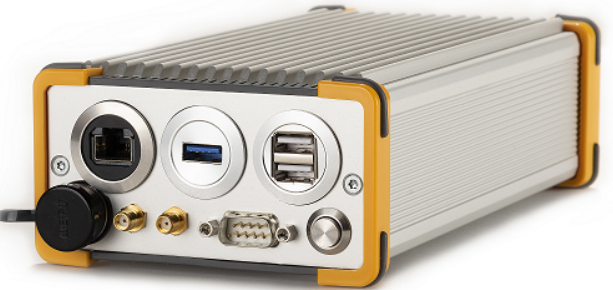
Figure 13. Photo of the GOOSE receiver @Fraunhofer IIS/Paul Pulkert.